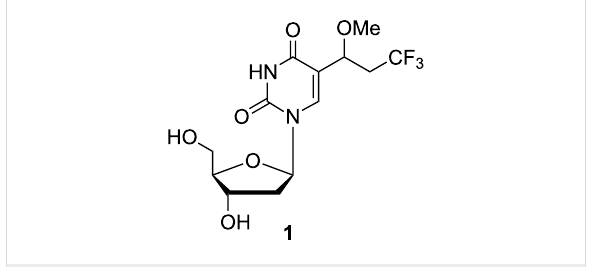
Figure 3: 5-(3,3,3-Trifluoro-1-methoxypropyl)-2'-deoxyuridine ( 1